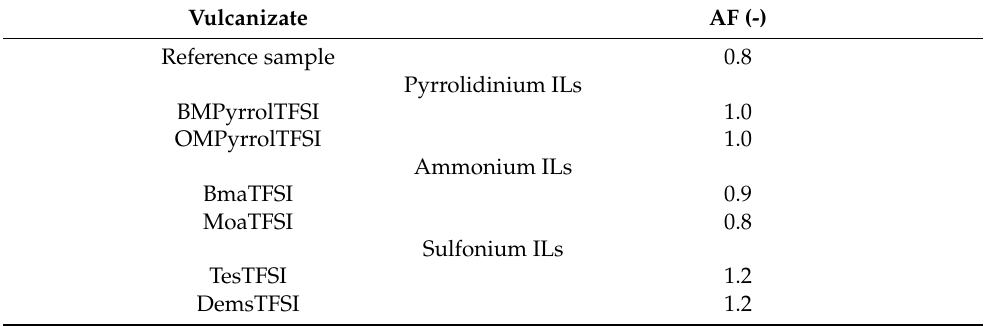
Table 8. Thermo-oxidative aging factor (AF) of NR vulcanizates (SD: AF ± 0.1). Vulcanizate AF (-)